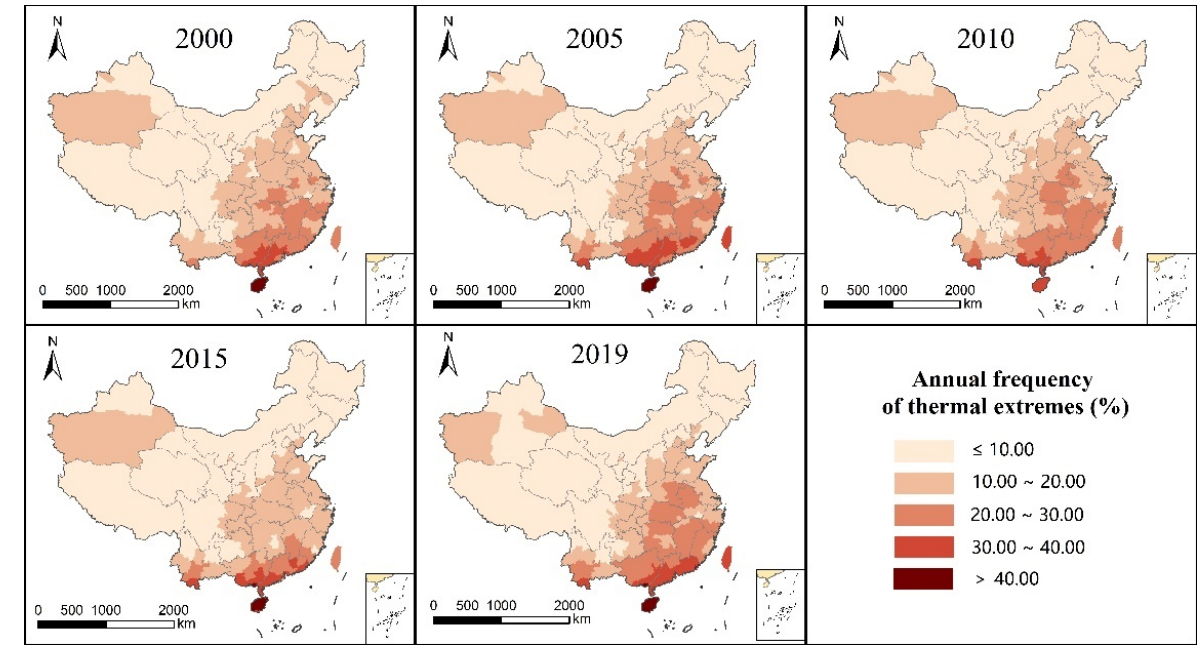
Figure 3. Annual mean distribution of UTCI in China from 2000 to 2020.